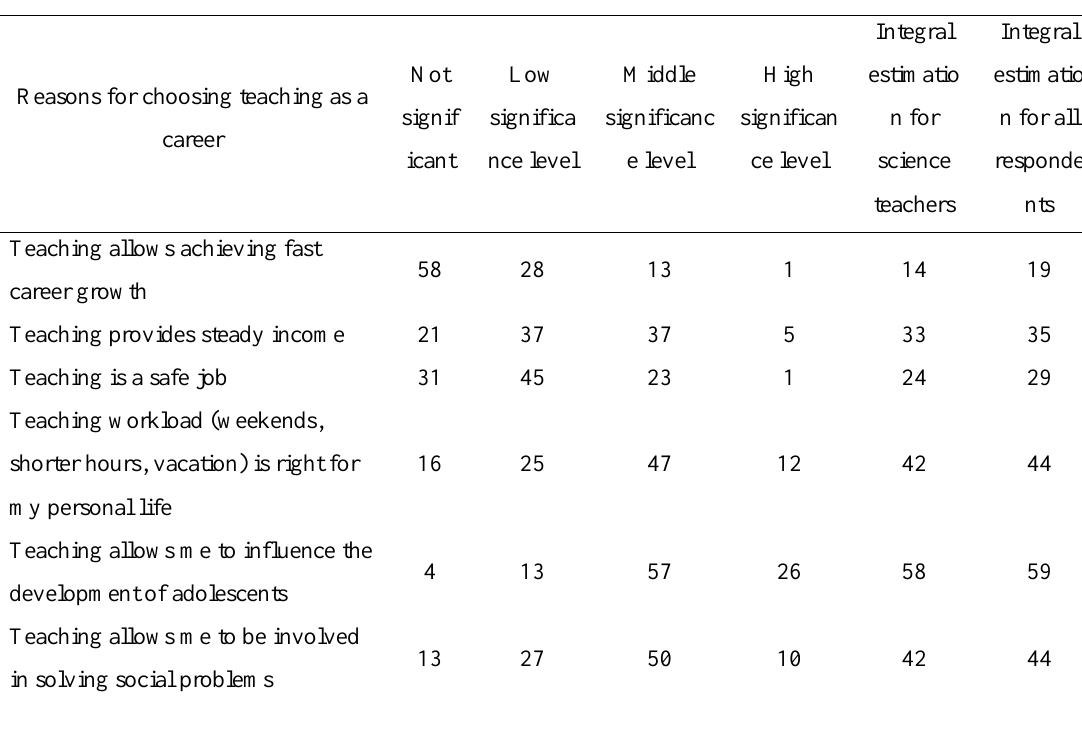
Table 1. The level of significance of the reasons for choosing the science teaching career, %